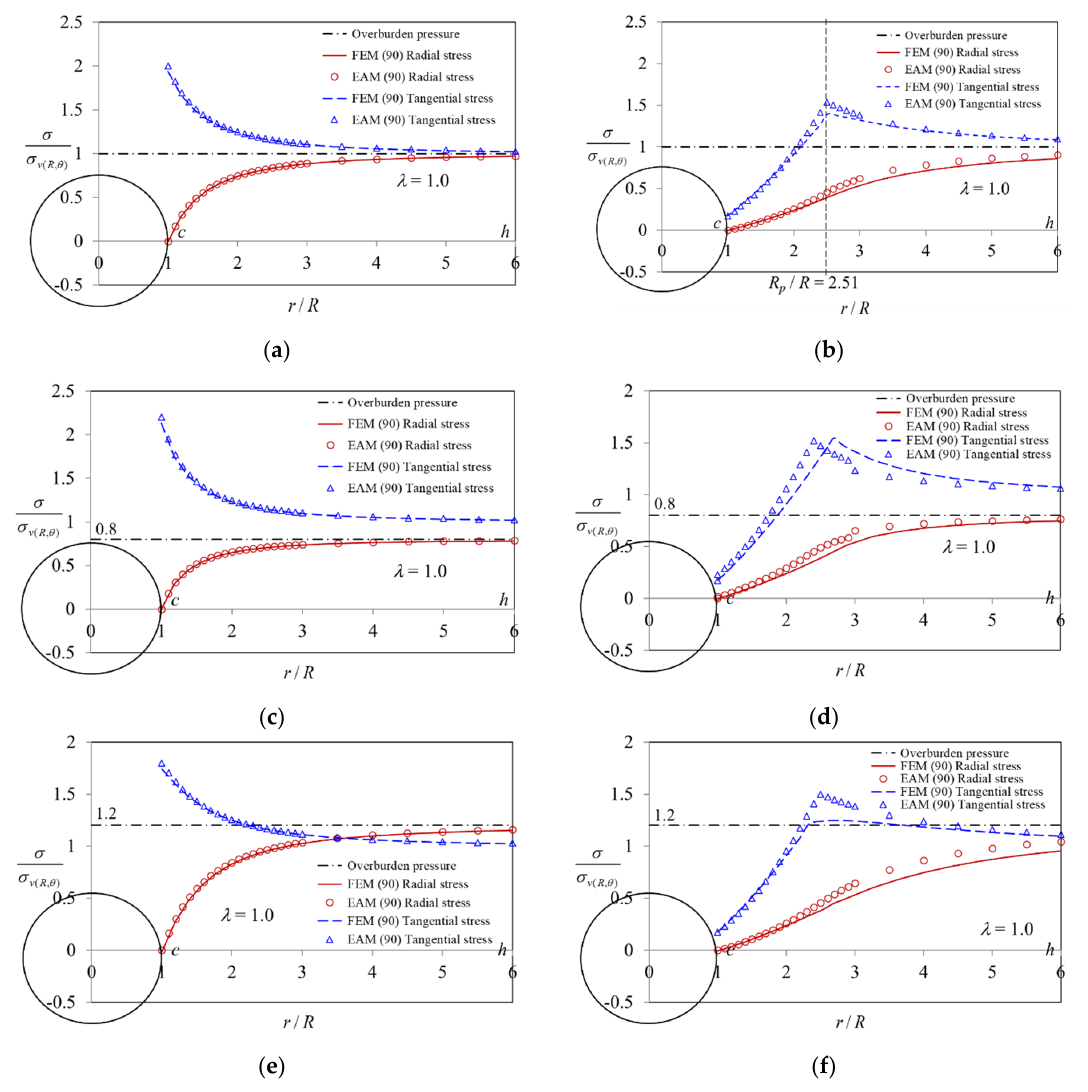
Figure 13. Comparison of the ground reaction around a circular tunnel in Case II ( θ = 90°) between the EAM and FEM with λ = 1.0, the distribution of tangential and radial stresses for ( a ) K o = 1.0 in the elastic media, ( b ) K o = 1.0 in the elastoplastic media, ( c ) K o = 0.8 in the elastic media, ( d ) K o = 0.8 in the elastoplastic media, ( e ) K o = 1.2 in the elastic media, and ( f ) K o = 1.2 in the elastoplastic media. Under the anisotropic stress condition ( K o = 0.8), the study of Case I (the area above the spring line, 0° < θ < 90°) supposes that the observation is along the ground surface line while a distance r is along the vertical line af and the initial stress equals zero, σ o = r · y = 0. Figures 14 and 15, respectively, show the analysis results in the elastic region and in the elastoplastic region. From each figure, it can be observed that the stress/displacement dis- tribution around the tunnel is especially concentrated along the overburden pressure line, and two stresses separate symmetrically along this line (dotted line in the Figures).